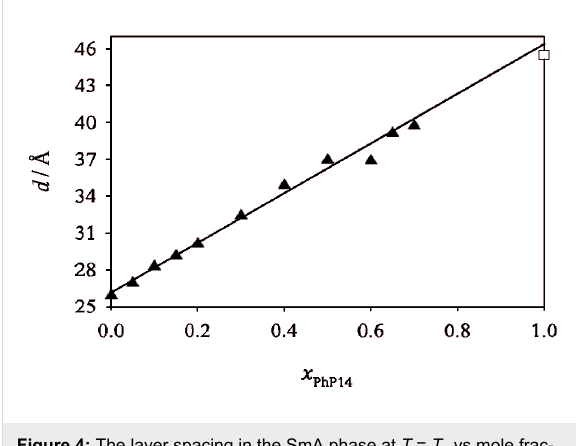
Figure 4: The layer spacing in the SmA phase at T = T c vs mole frac- tion for the system 2PhP / PhP14 (filled triangles) and calculated value of the molecular length for pure PhP14 from molecular modelling (open